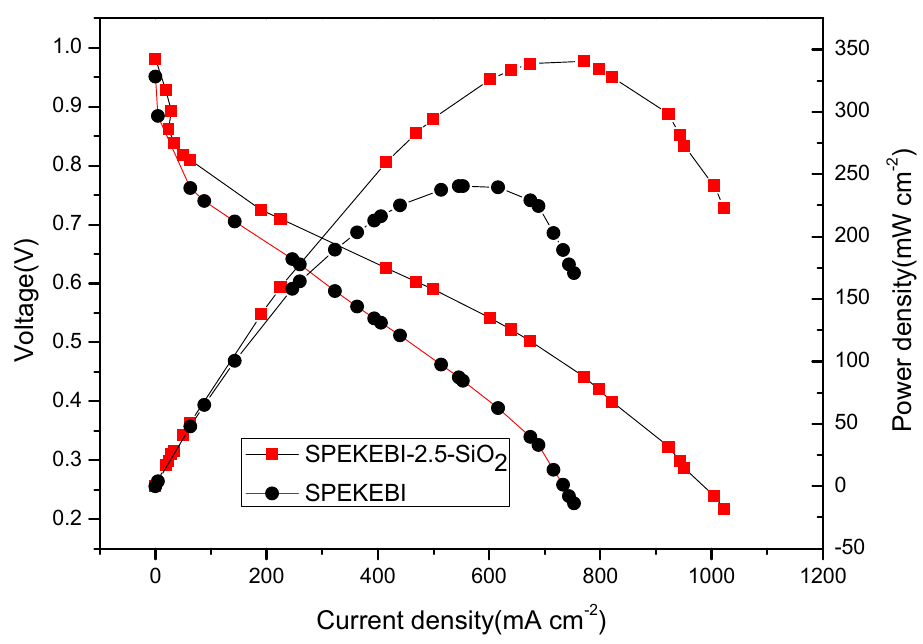
Figure 11. Single fuel cell performance of SPEKEBI-2.5-SiO 2 and SPEKEBI membranes operating under 100% RH at 75 °C.